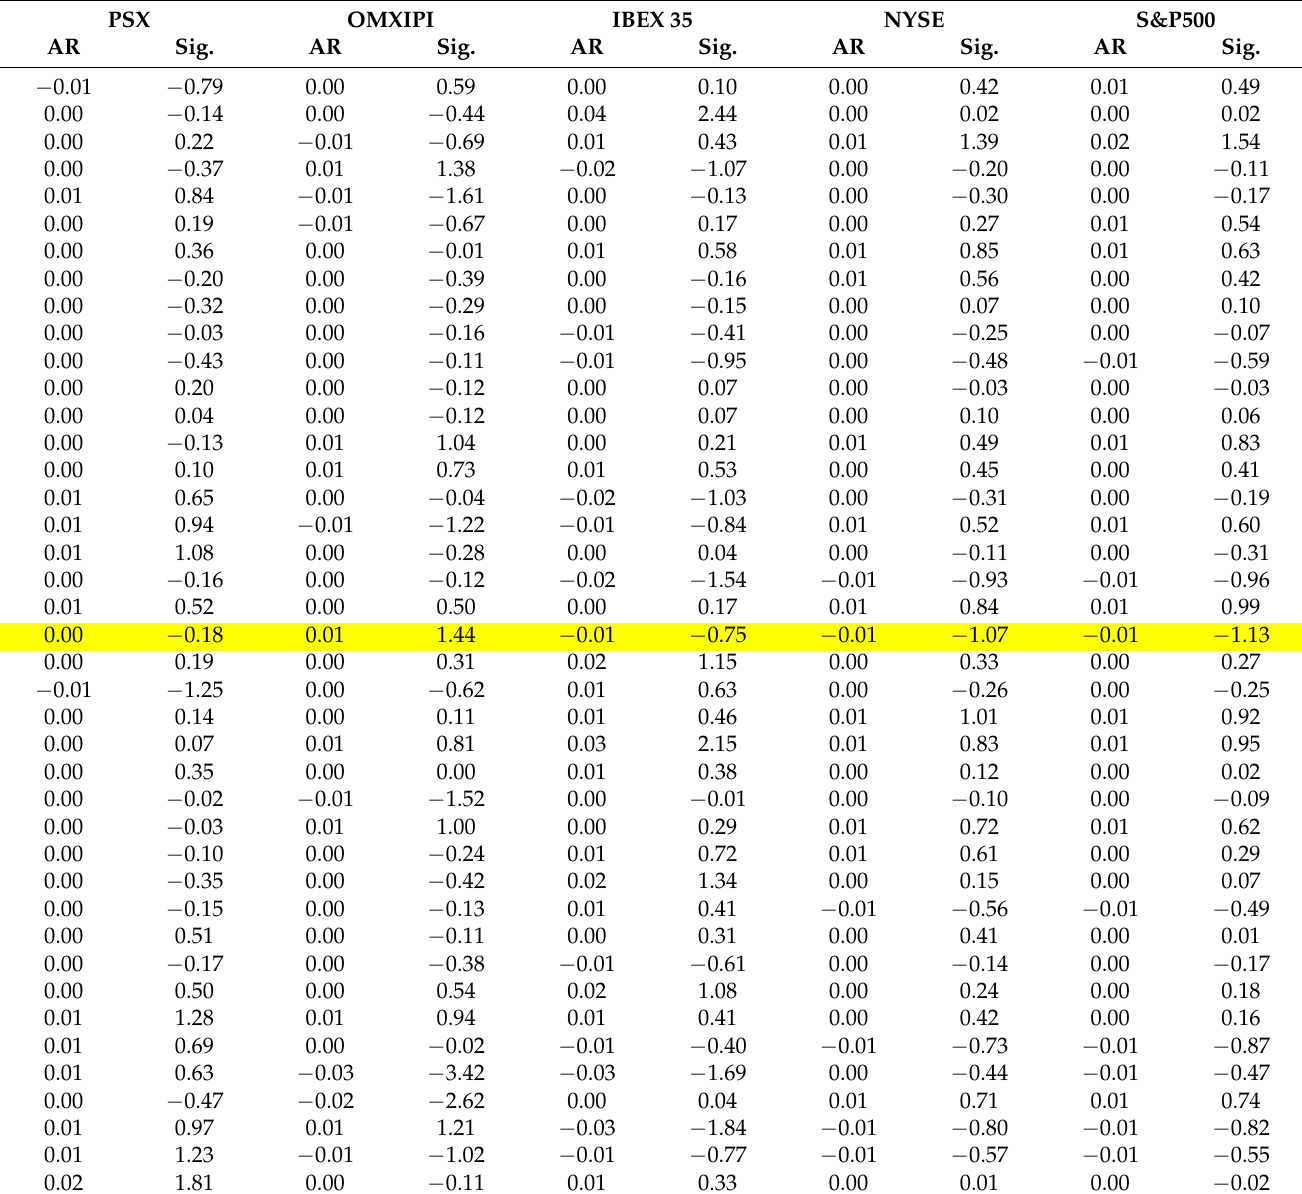
Table A21. Abnormal returns of the ( − 20, +20) event window for Leak of Panama papers (Jurgen Mossack